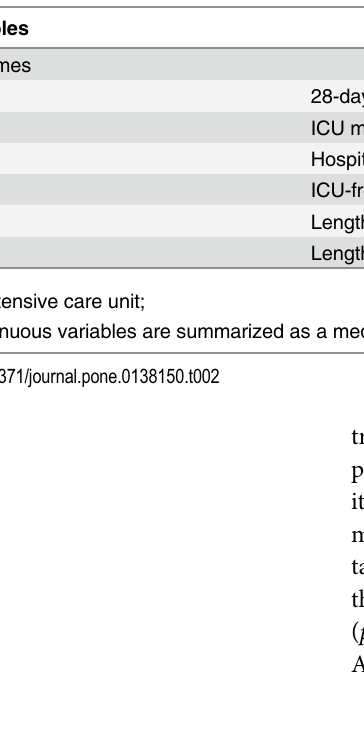
Table 3. Biochemical markers in predicting treatment failure and 28-day mortality. Total (n = 171) Treatment success (n = 105) Treatment failure (n = 66)